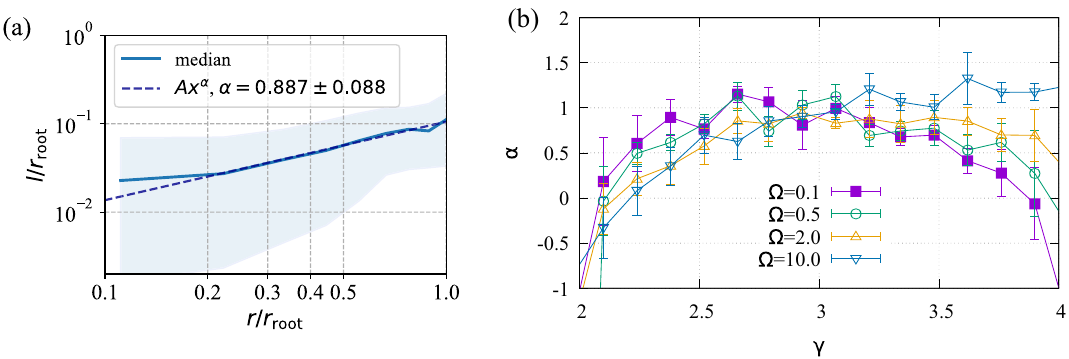
Figure 7. ( a ) A power law relationship is found for the median segment length in terms of segment radius calculated using SALVO. The figure shows median values of l / r root vs r / r root , a power law fit (dashed line), and the 25th and 75th percentiles (light blue shading). To calculate the length–radius relation, segments are binned 0.9 . ( b ) The length–radius exponent, α , is close to one for from trees with N > 2000 , 2.75 < γ < 3.25 , (cid:31) = trees grown with 2.5 < γ < 3.5 . To calculate the length–radius relation, segments are binned from trees with N > 2000 and specific γ and (cid:31) values and fits similar to Panel ( a ) are made. Error bars represent uncertainty in the